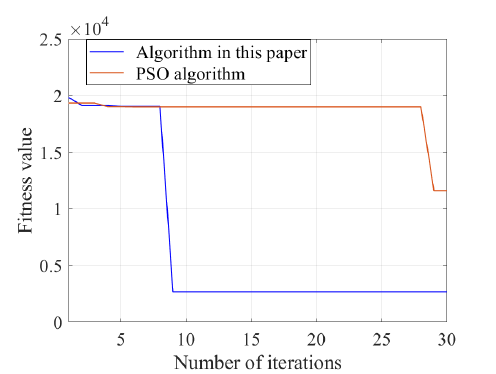
Fig. 16. Comparison of the parameter self-optimization curves of improved